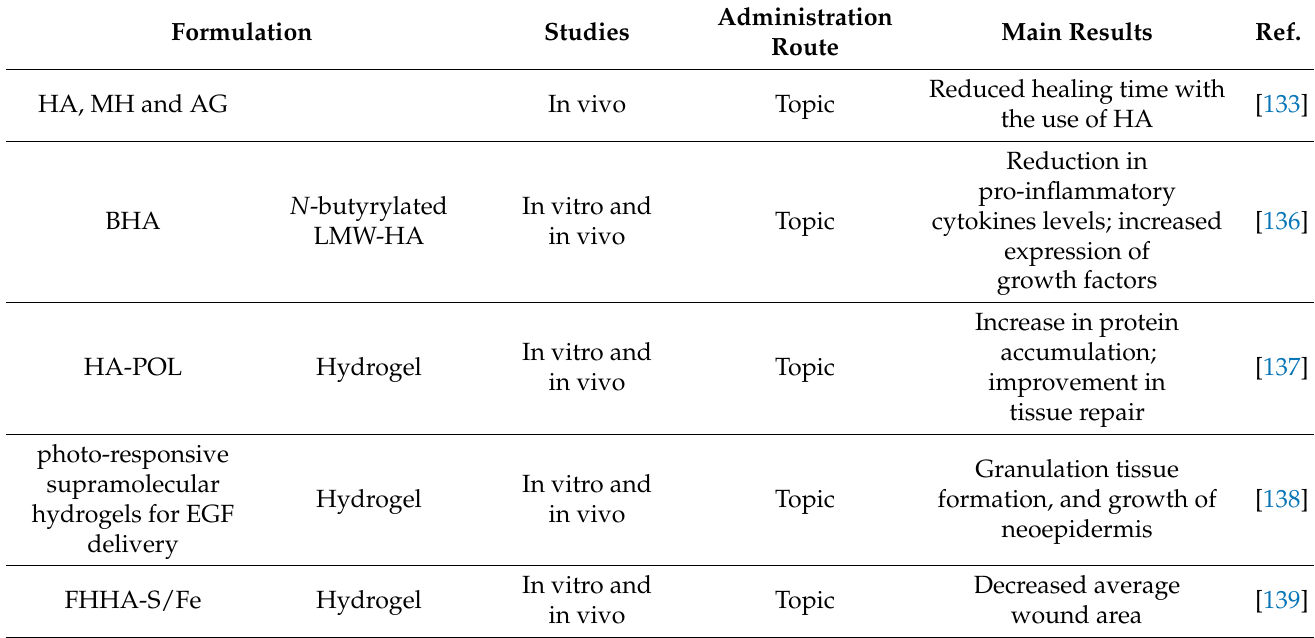
Table 3. Study summaries where HA is used for